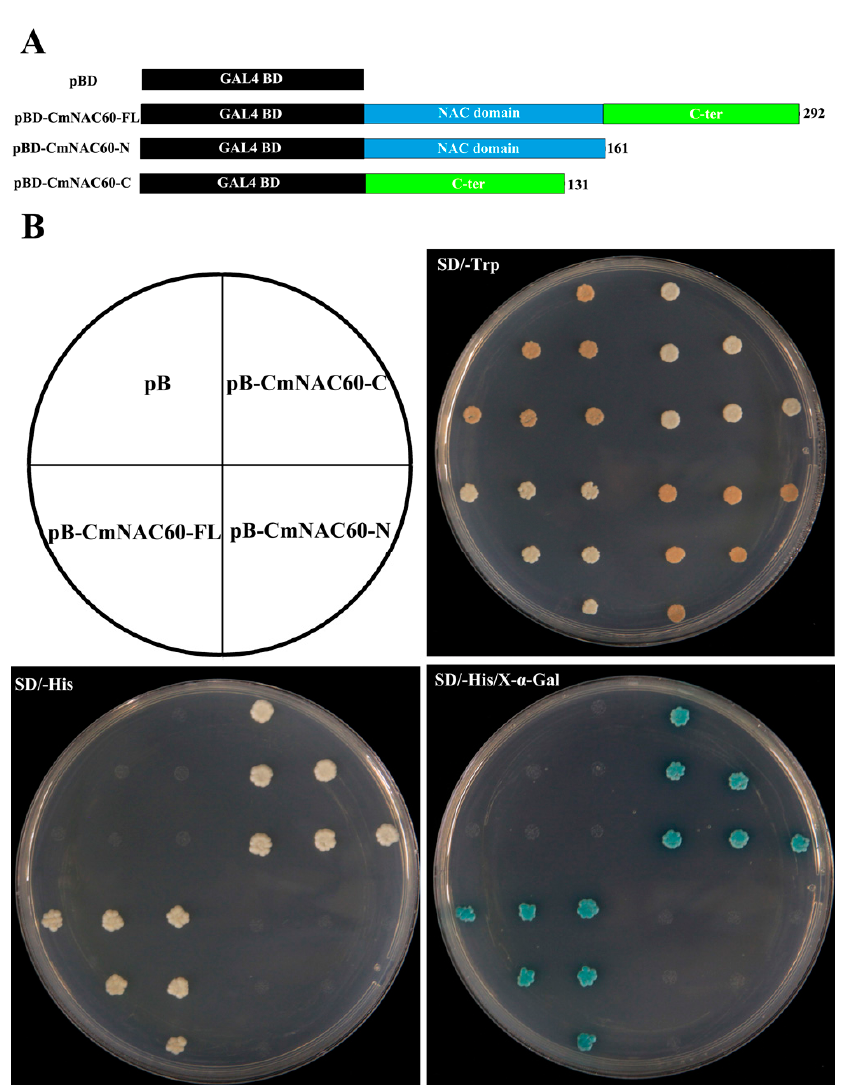
Figure 5. Transactivation activity assay of CmNAC60 in yeast cells. ( A ) Diagram showing that full-length protein (CmNAC60-FL), N-terminal fragment (CmNAC60-N), and C-terminal fragment (CmNAC60-C) of CmNAC60 were fused with a GAL4 DNA binding domain. The pBridge vector was used as a negative control. ( B ) The transformed yeasts were dripped on the SD/-Trp, SD/-His, and SD/-His supplemented with X- α -Gal medium, respectively.